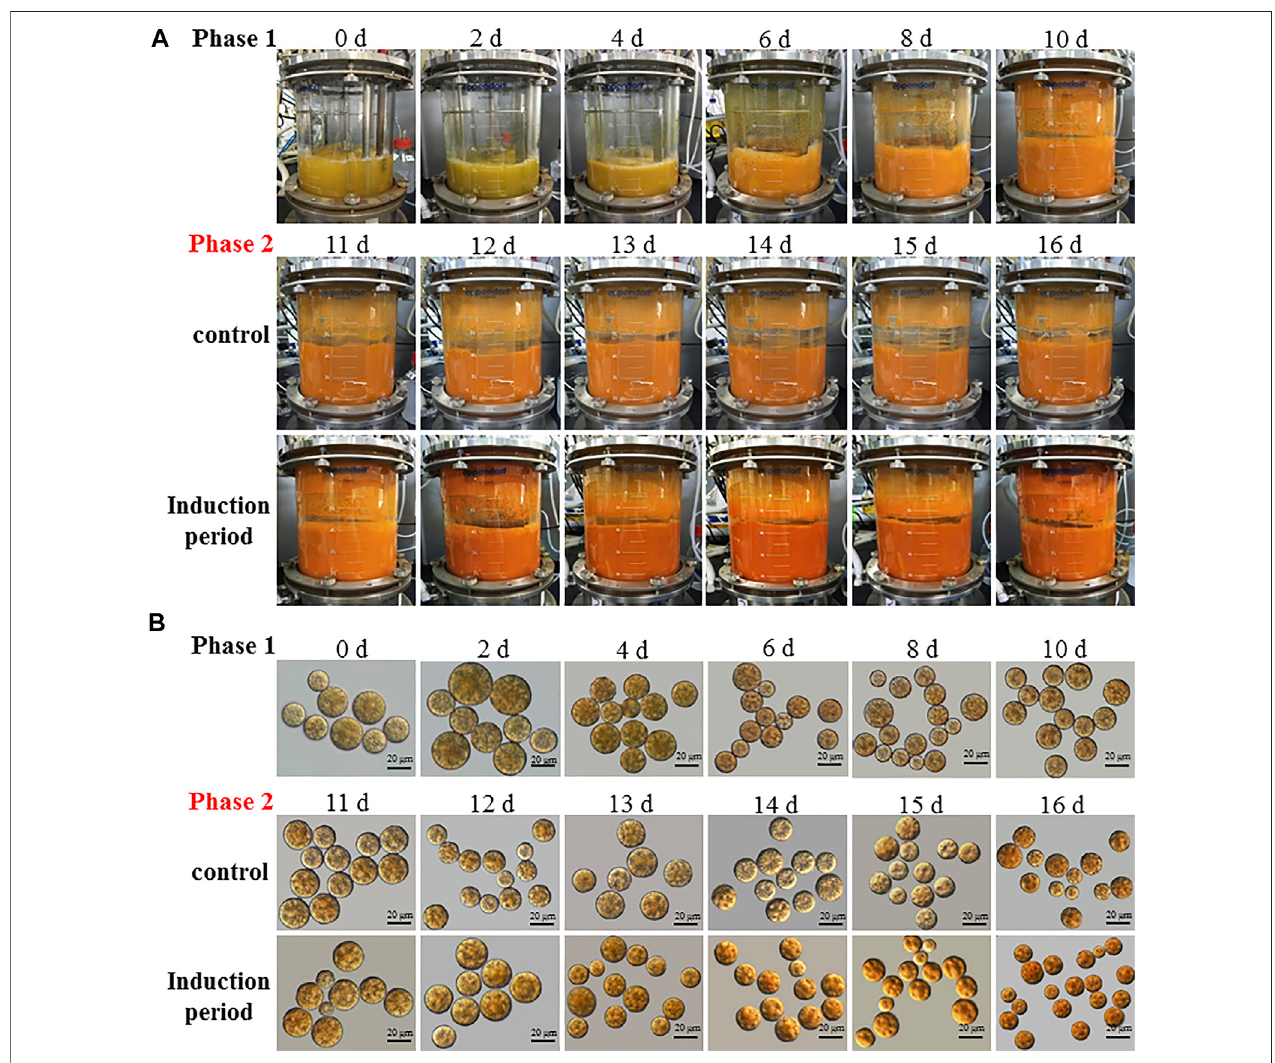
FIGURE 6 | The culture appearance (A) and morphological (B) changes of C. zo fi ngiensis cells during the induction period in the 7.5 L fermentors. Induction conditions, the C/N ratio of the feeding medium change to 180:1 with the addition of 10 mg L − 1 GA3 and 200 mM NaCl at the end of 10 days.